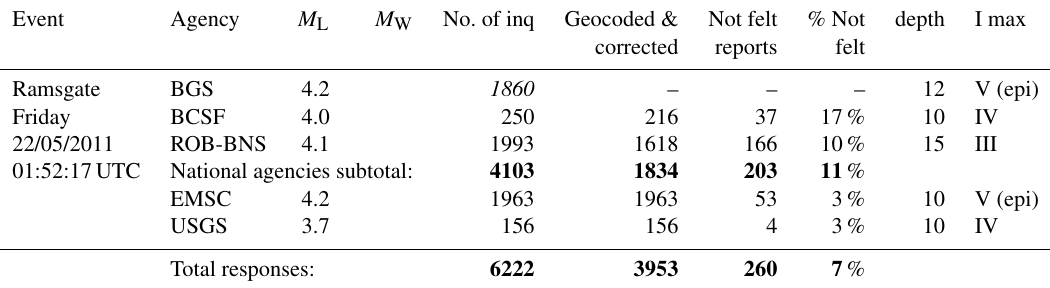
Table 2. Institutional macroseismic datasets for the 2015 Ramsgate earthquake. When street addresses were available, response locations were geocoded for location improvement. Intensities were floor-level corrected. Only total amount of geocoded and corrected intensity points are used for grid cell intensity analysis in this study. ML: local magnitude; MW: moment magnitude; no. of inq.: number of inquiries; I max: maximum intensity. No. of inq. gathered by BGS (in italics) are taken from the BGS website but were not used in the individual intensity